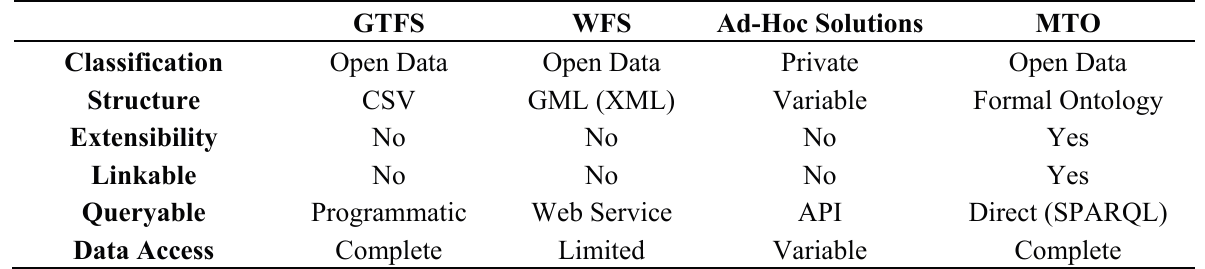
Table 1. Comparison between formats for transport information